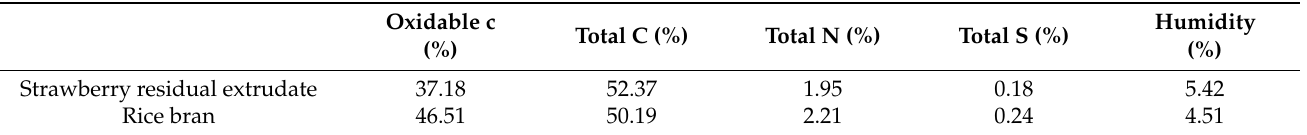
Table 2. Physicochemical amendment